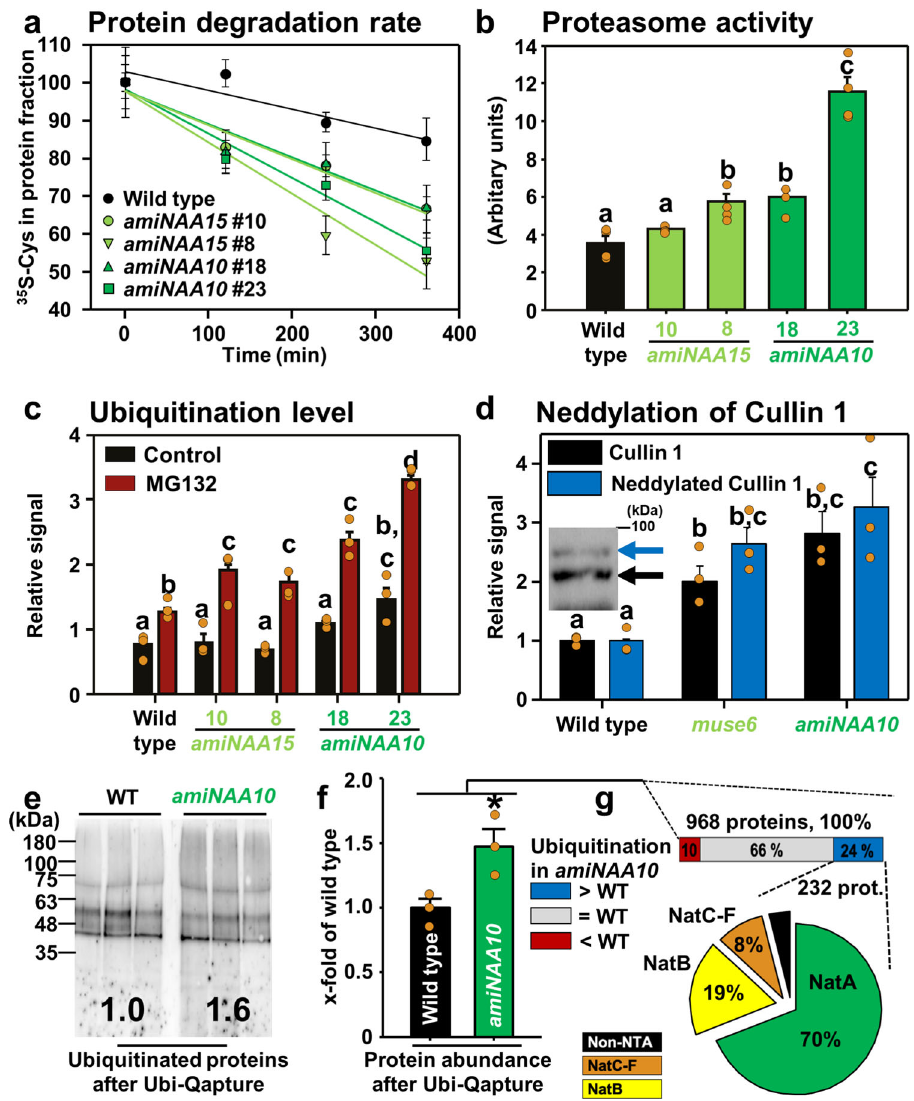
Fig. 1 Depletion of NatA activity causes enhanced degradation of proteins via the ubiquitin-proteasome system. a Time-resolved analysis of protein degradation rate in leaves of wild type (black) and four individual lines depleted for the ribosome anchoring (NAA15, light green) or the catalytically active subunit (NAA10, dark green) of the NatA complex. n = 4 biologically independent samples, except for WT 360 min, amiNaa10 # 18 360 min, amiNaa10 #23 120 min, 240 min, amiNaa15 #8 120 min, 360 min, and amiNaa15 #10 360 min n = 3. b Proteasome activity in wild type and NatA activity depleted plants. Different letters indicate individual groups identi fi ed by pairwise multiple comparisons with a Holm-Sidak, one-way ANOVA ( p < 0.05, n = 4 biologically independent samples, except for amiNaa10 #18 n = 3). c Relative level of poly-ubiquitinated proteins as determined with the ubiquitin-speci fi c antiserum ( α -UBQ11; Agrisera) in leaves of wild type and NatA depleted plants in the presence (red) or absence (black) of the proteasome inhibitor MG132. Different letters indicate individual groups identi fi ed by pairwise multiple comparisons with a Holm-Sidak, one-way ANOVA ( p < 0.05, n = 3 biologically independent samples). d Abundance and activation status of Cullin-RING E3 ligase (CRL) complexes as determined by neddylation of Cullin isoform 1 in wild type and transgenic lines depleted of NAA15 ( muse6 ) and NAA10 ( amiNAA10 ). Different letters indicate individual groups identi fi ed by pairwise multiple comparisons with a Holm-Sidak, one-way ANOVA ( p < 0.05, n = 3 biologically independent samples) e Immunological detection of poly-ubiquitinated proteins using an ubiquitin-speci fi c antibody ( α -UBQ11; Agrisera) in the wild type and amiNAA10 line 23 ( amiNAA10 ) after selective enrichment with the Ubi-Qapture Q TM matrix. f Protein amount of af fi nity enriched bona fi de poly-ubiquitinated proteins. Asterix indicate individual groups identi fi ed by pairwise multiple comparisons with a Holm-Sidak, one-way ANOVA ( p < 0.05, n = 3 biologically independent samples) g Quantitative proteomics of bona fi de poly-ubiquitinated proteins revealed that 24% of quanti fi ed proteins (232 proteins) were signi fi cantly (student t-test, p < 0.05) more ubiquitinated in amiNAA10 (>1.5-fold more than wild type) or either only found in all amiNAA10 replicates ( n = 3 biologically independent samples). The pie chart depicts the classi fi cation of Nat substrates in the fraction of signi fi cantly more ubiquitinated proteins in amiNAA10 plants. Data are shown as mean ± standard error. Immunological detections of proteins quanti fi ed in c , d were independently repeated and blots are shown in the source data fi le.